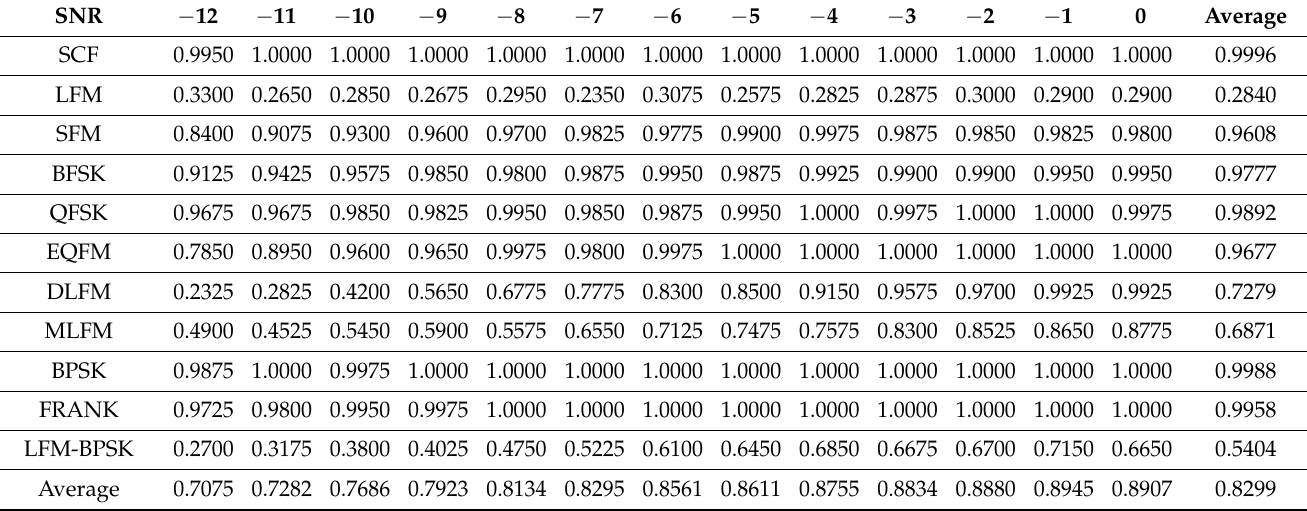
Table A19. Semi-supervised classification results with the datasets in Situation Dataset 5 without self-paced data augmentation ( T cycle = 200, NUM =